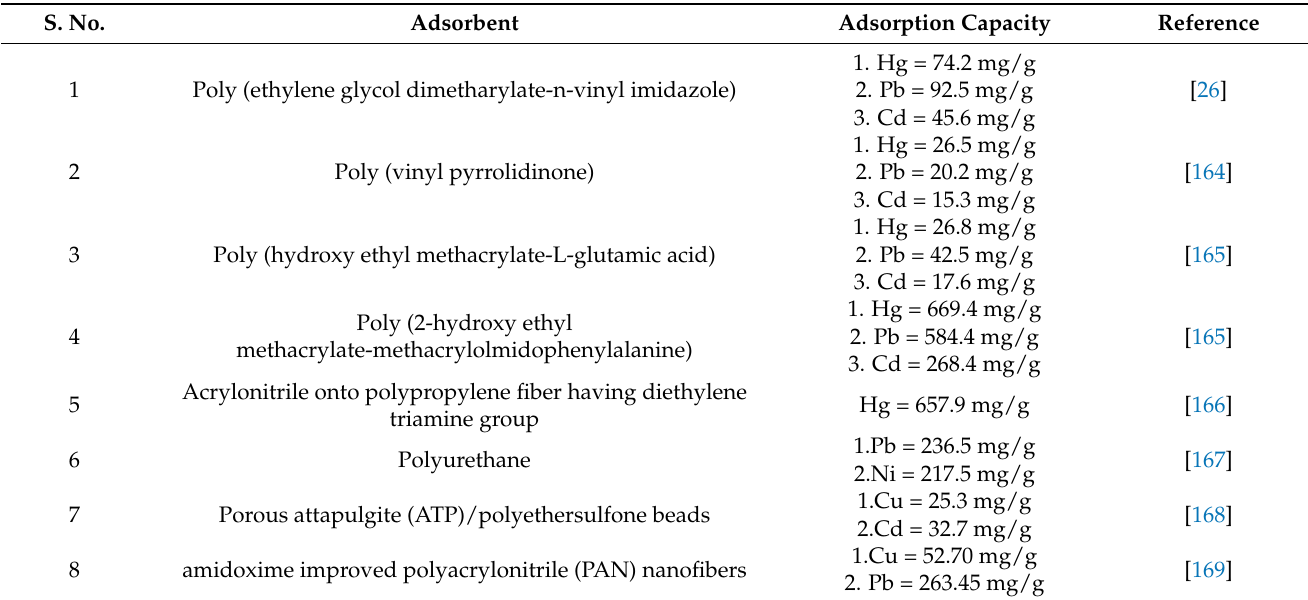
Table 3. Different Polymeric adsorbents used for removal of various toxic metal ions. S.